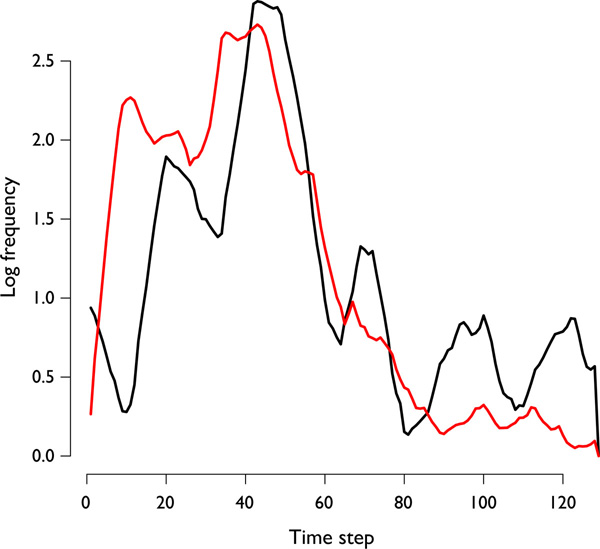
A lagged correlation between two time series. An example of two set time series that contain a lead-lag correlation.